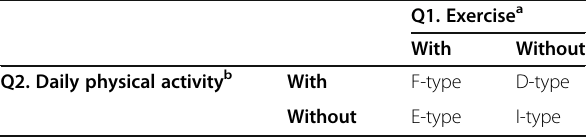
Table 1 Category of physical activity type